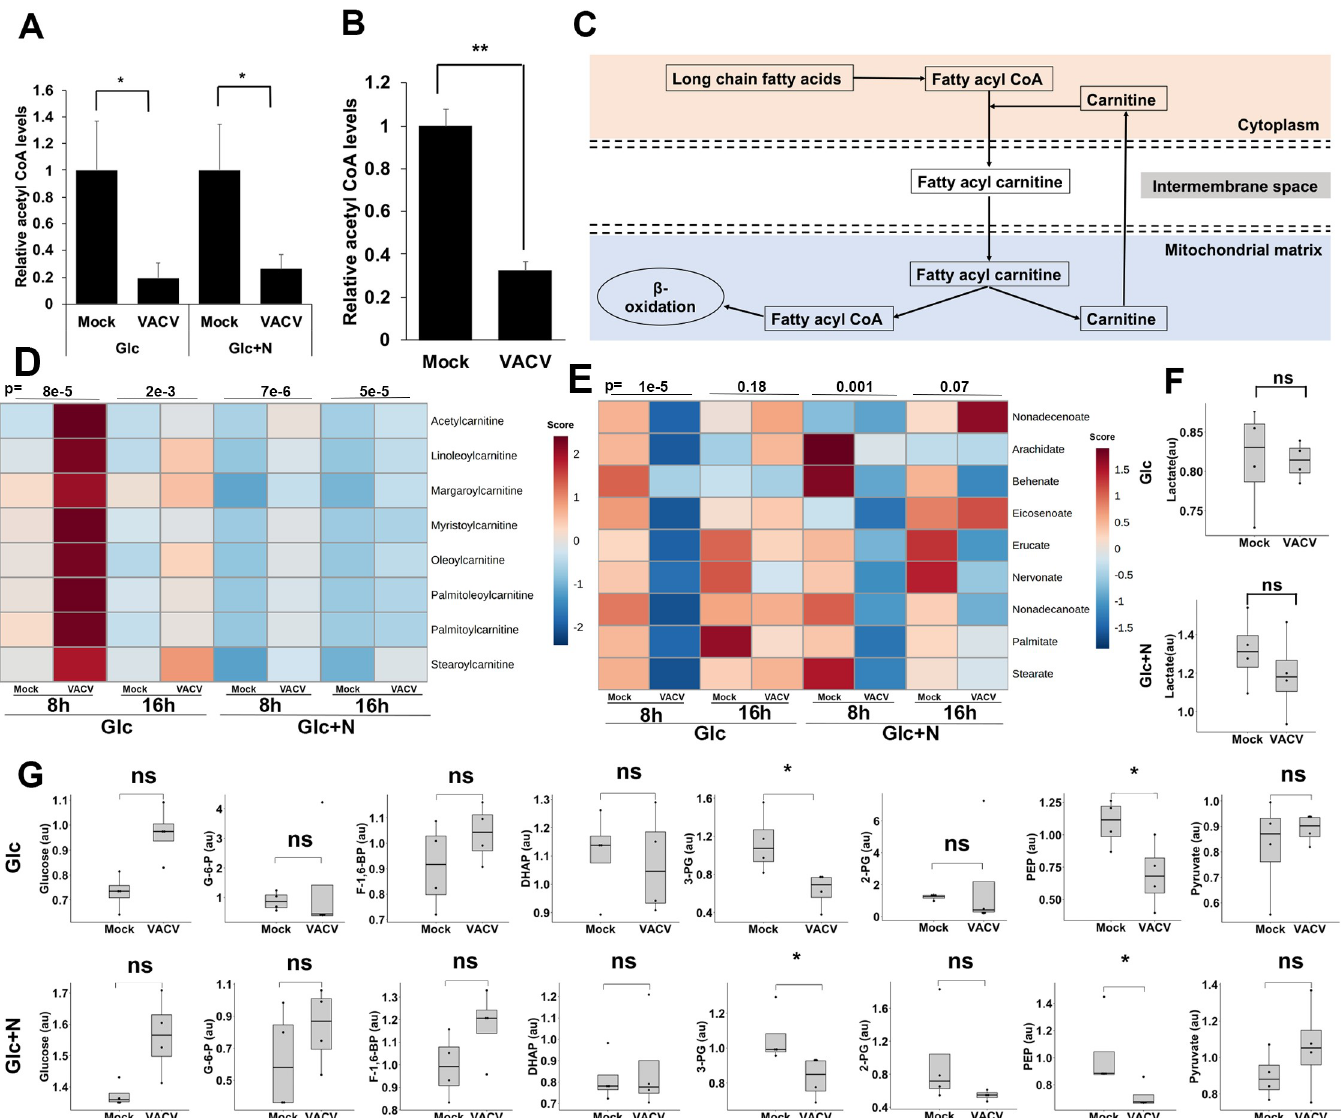
Fig 3. VACV infection alters the TCA cycle-related metabolism. (A) A decrease in Acetyl-CoA upon VACV infection in HFFs cultured in media without glutamine. The level of Acetyl-CoA at 8 hpi in the metabolic profiling of Fig 1A was shown. (B) VACV infection decreases the level of acetyl CoA in HFFs cultured in medium containing glutamine. HFFs infected with WT VACV at an MOI of 2 in media with glucose plus glutamine and the Acetyl-CoA level was measured at 8 hpi using an Acetyl-CoA assay kit. (C) A simplified overview of carnitine metabolism in β -oxidation. The long-chain fatty acids are acylated and then carnitylated by carnitine palmitoyltransferase system, which is then transported into the mitochondrial matrix for β -oxidation to fuel the TCA cycle. (D) VACV infection increases the levels of carnitine-conjugated fatty acids. The metabolic profiling data of fatty acyl carnitines in VACV-infected HFFs (Supplementary File S2) was uploaded to the MetaboAnalyst tool and then a hierarchically clustered heatmap was generated using Ward’s minimum variance and Euclidean distance measure. Color keys indicate the levels of different metabolites; blue: lowest, red: highest. The number on top of the plots represent the p-values comparing the average levels of indicated metabolites levels in mock- and VACV-infected HFFs (E) The levels of long-chain fatty acids are reduced in VACV-infected HFFs. The metabolic profiling data of long-chain fatty acids in VACV-infected HFFs (Supplementary File S2) was processed as in Fig 3D. (F) VACV infection does not affect the level of lactate. The level of lactate in HFFs infected with MOI-3 of WT-VACV in media with glucose (Glc) or glucose plus asparagine (Glc+N) at 8 hpi was determined by global metabolic profiling in Fig 1A. (G) The glycolysis intermediates are either unaffected or reduced by VACV infection. The levels of glycolysis intermediates in HFFs infected with MOI-3 of WT-VACV in medium with glucose (Glc) or glucose plus asparagine (Glc+N) at 8 hpi as determined by global metabolic profiling in Fig 1A. Error bars represent the standard deviation of at least three biological replicates. ns, P > 0.05; � , P � 0.05; �� , P � 0.01; ��� , P � 0.001; ���� , P � 0.0001.